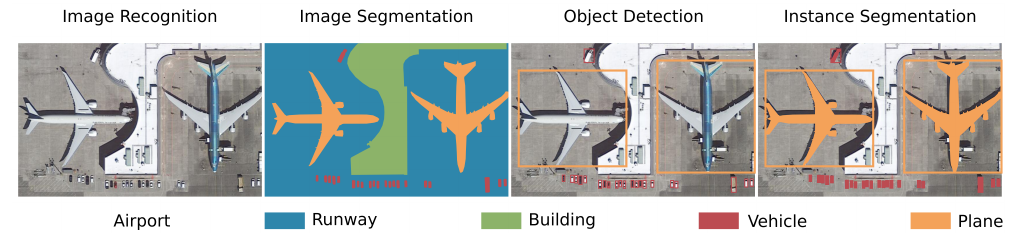
Figure 3. Examples for the tasks of: image recognition, assigns a single label to a whole image; image segmentation, densely classifies each pixel, object detection: locates and classifies specific objects in an image by providing a bounding box; and instance segmentation, provides a segmentation mask for detected objects within a bounding box. The example image is from the DOTA dataset, an object detection dataset of high resolution RGB aerial images